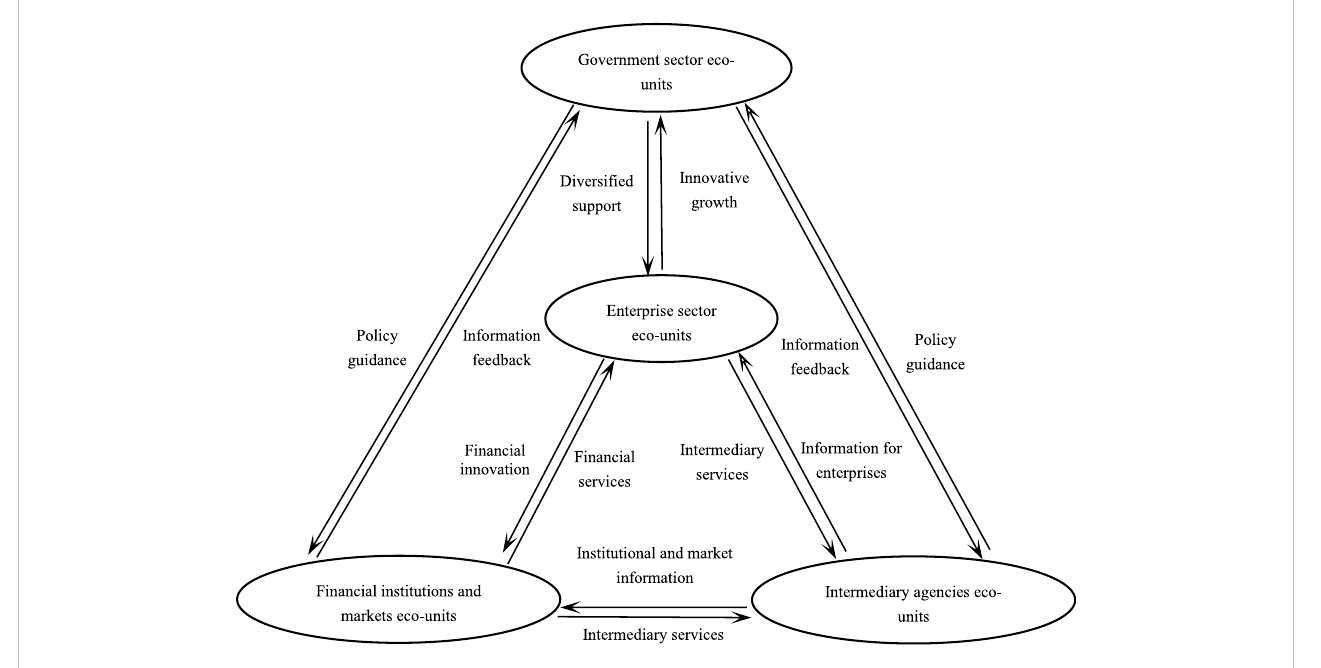
FIGURE 1 A green fi nancial infrastructure ecosystem based on symbiotic